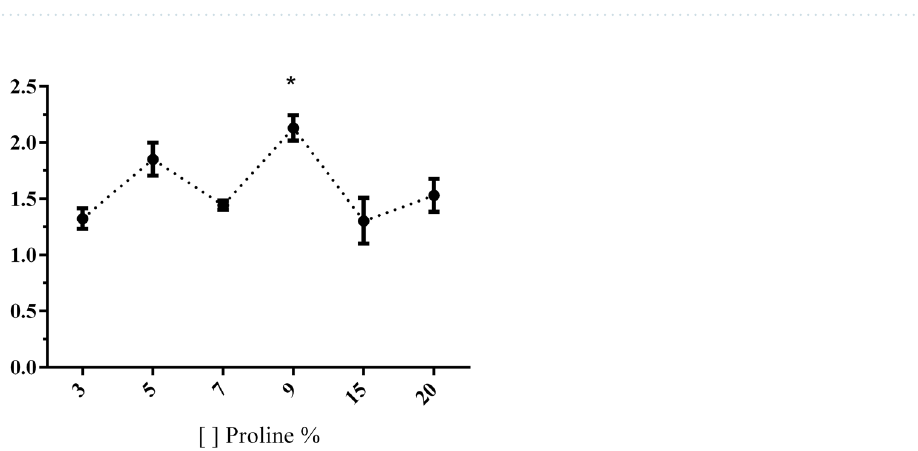
Table 4. Effect of variables on L-asparaginase production by Penicillium cerradense evaluated by Fractional Factorial Design.